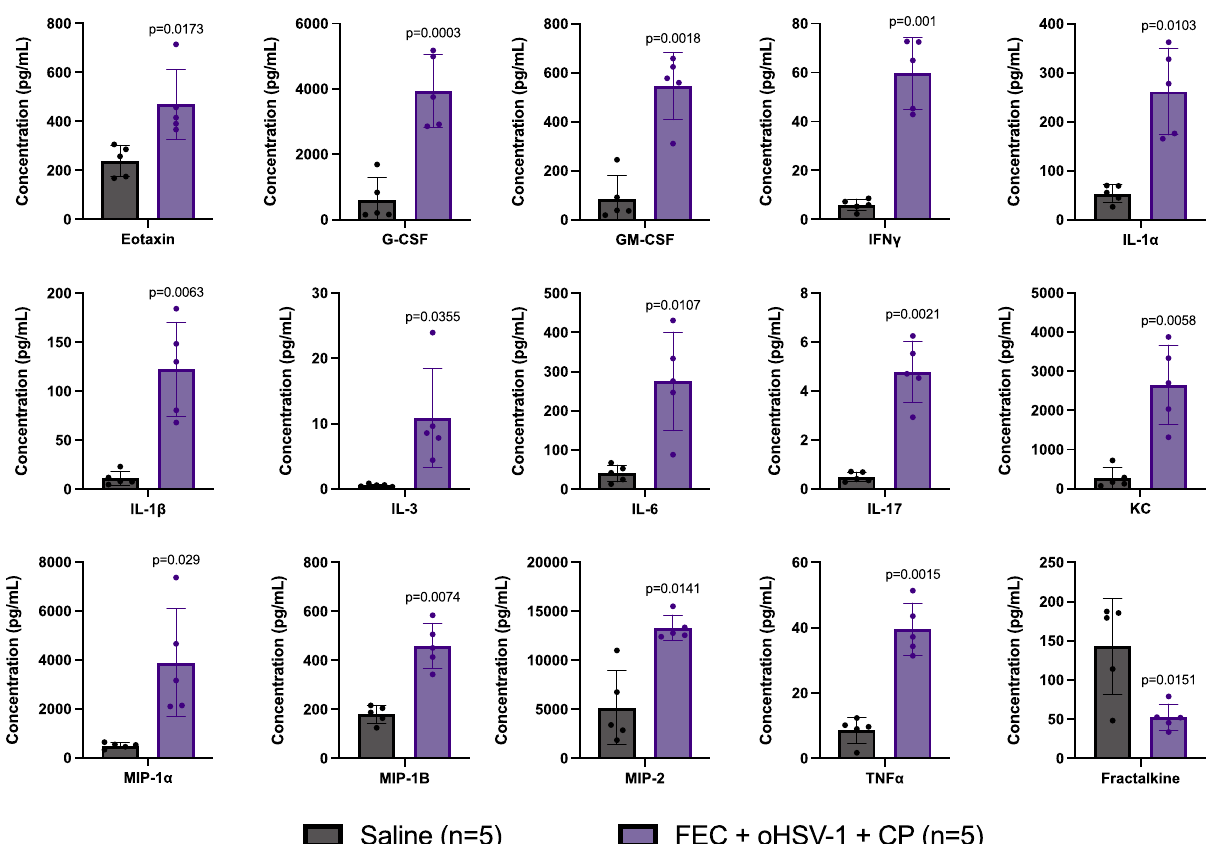
Fig. 3 Cytokine analysis shows that treatment with FEC + oHSV-1 + CP signi fi cantly alters the expression of a variety of cytokines. C57/Bl6 mice bearing E0771 tumors were treated with saline or FEC + oHSV-1 + CP. Mice were sacri fi ced on day 10 treatment and tumors fl ash frozen. Tumor lysates were made and sent for cytokines expression analysis. All values are reported as a concentration (pg/mL). Two-tailed paired t test was used for statistical analyses. Error bars are representative of the standard